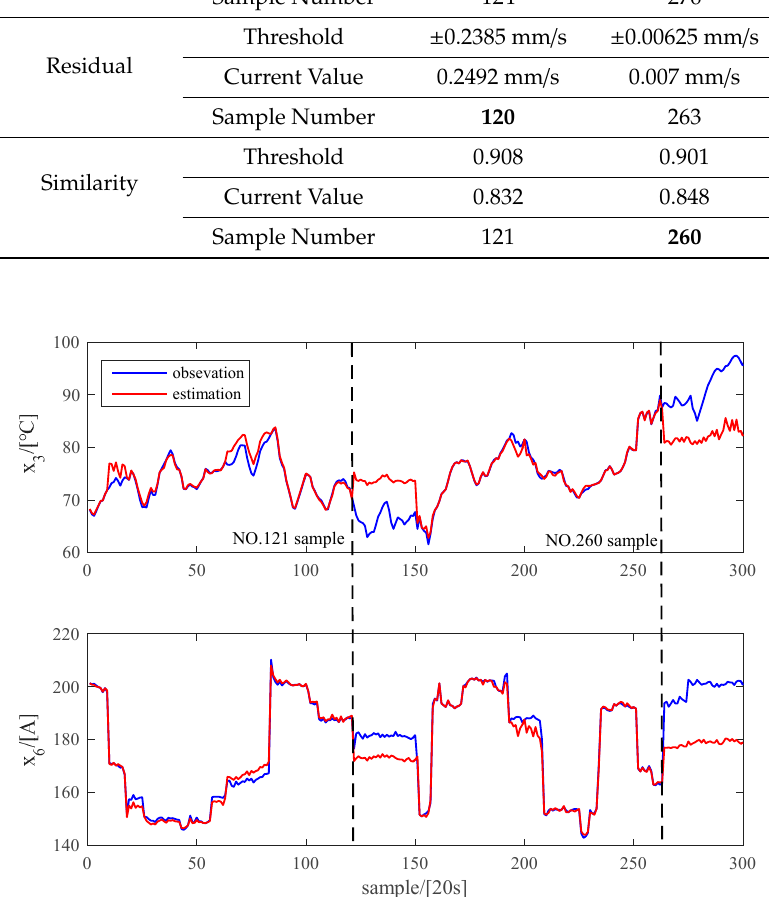
Figure 10. The trend of x 3 and x 6 while alarms.